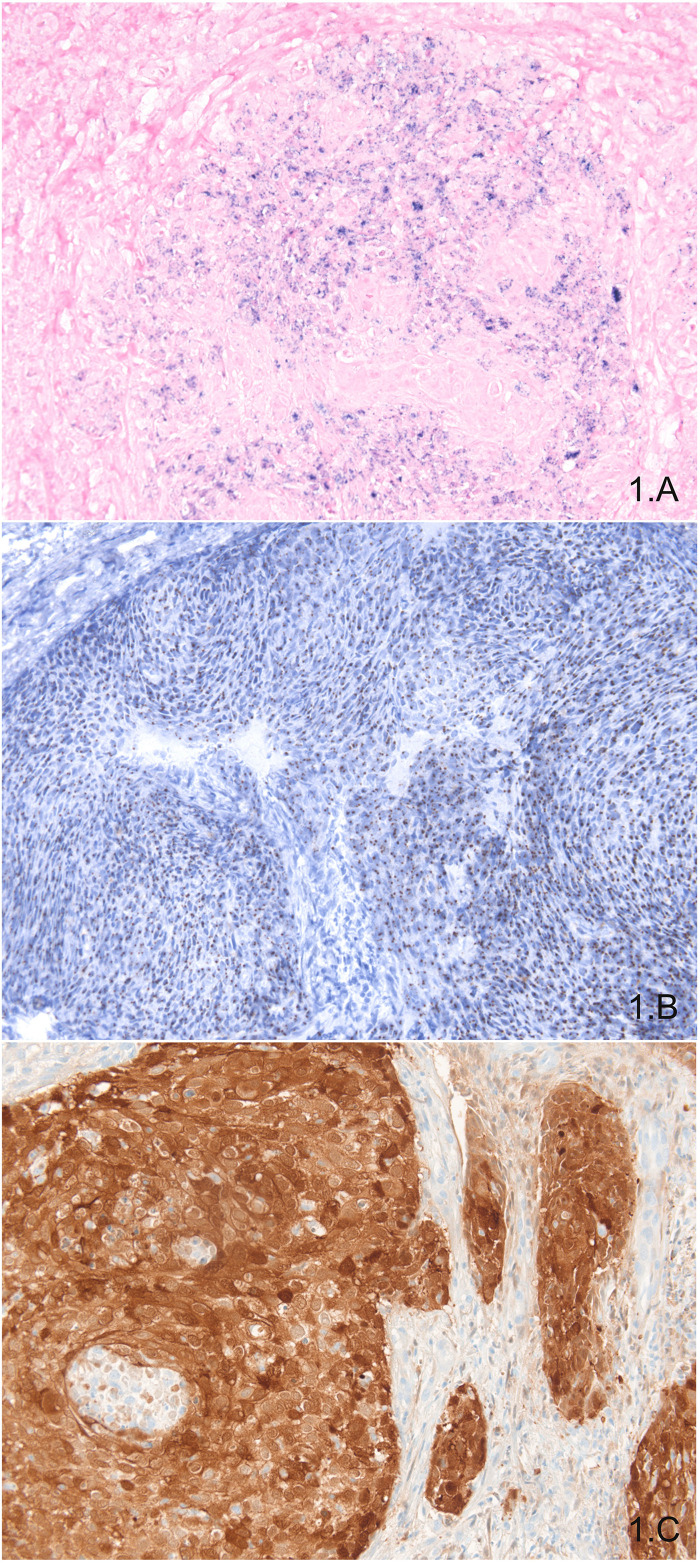
In situ exploration of HPV presence: DNA ISH showing blue punctate staining in tumor cells (A); RNA ISH showing brown punctate staining in tumor cells (B); P16 immunohistochemistry showing diffuse and intense nuclear and cytoplasmic staining in almost all tumor cells (C).